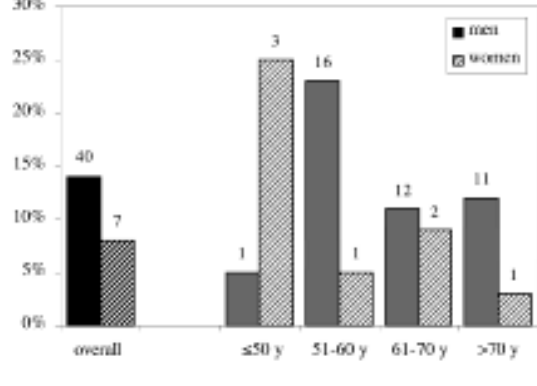
Evaluation of first experiences with CardioCard ® using a mailed questionnaire.